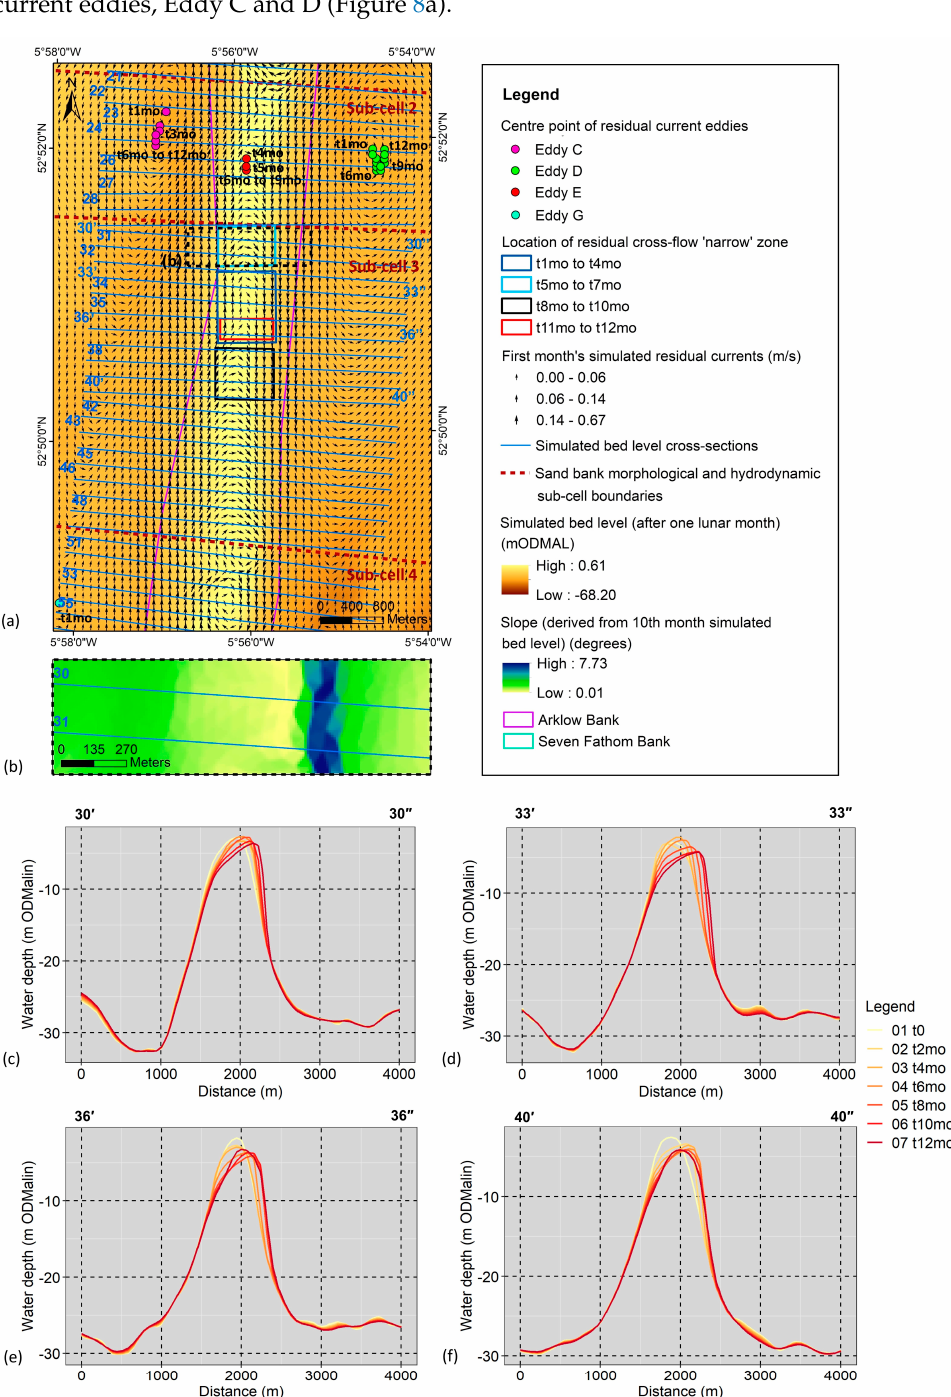
Figure 8. Morphodynamics and hydrodynamics at Sub-cell 3 of Arklow Bank. ( a ) Simulated bed level change after one lunar month and associated residual current vectors, overlain by the location of the centre point of residual eddies from residual currents during each subsequent lunar month simulation; ‘t6mo’ is the sixth lunar simulation month. ( b ) Slope derived from the resulting bed level after 10 lunar month simulation, overlain by cross-section L30. ( c – f ) Simulated bed level over a one year simulation at cross-sections 30, 33, 36, and 40; ‘t0’ is the starting bed level, and ‘mo’ is subsequent